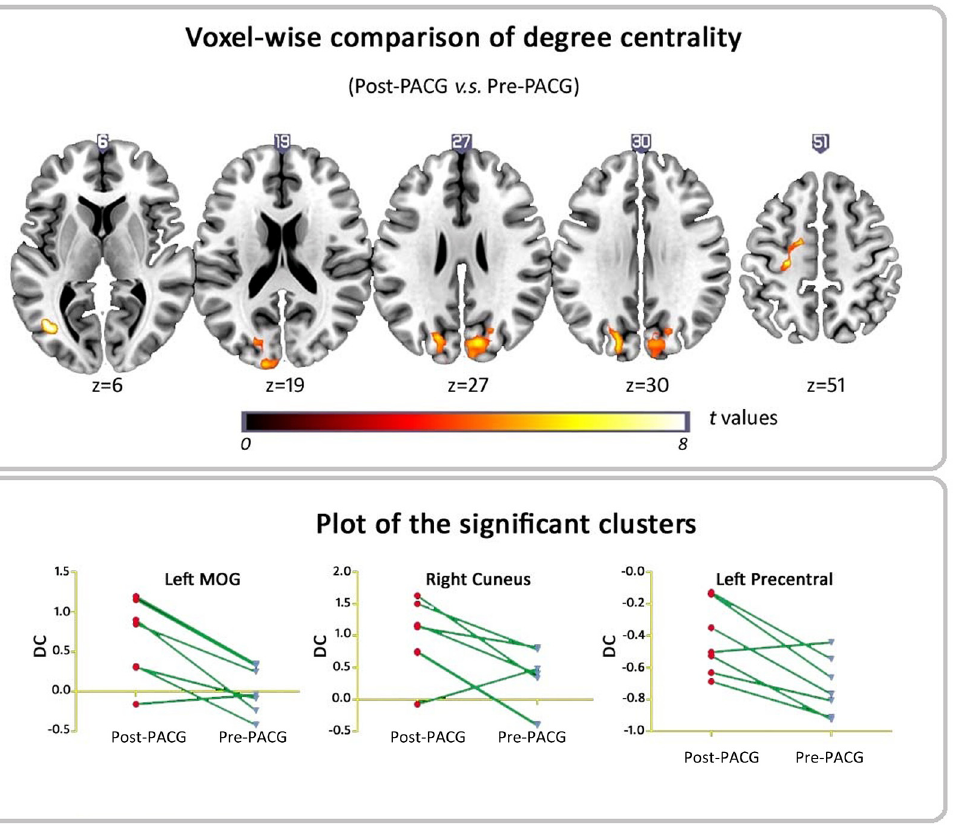
Fig 3. Voxel-wise comparison of DC between Post- and Pre-PACG patients. Areas of significant ( p < 0.05, GRF corrected) DC difference between Post- and Pre-PACG patients. Hot (cool) color represents higher (lower) DC in the Post-PACG group compared with the Pre-PACG group. a) Axial view and b) DC values of significant different clusters (left MOG and right cuneus and left precentral gyrus) between Post- and Pre-PACG patients. Abbreviation: MOG, middle occipital gyrus.